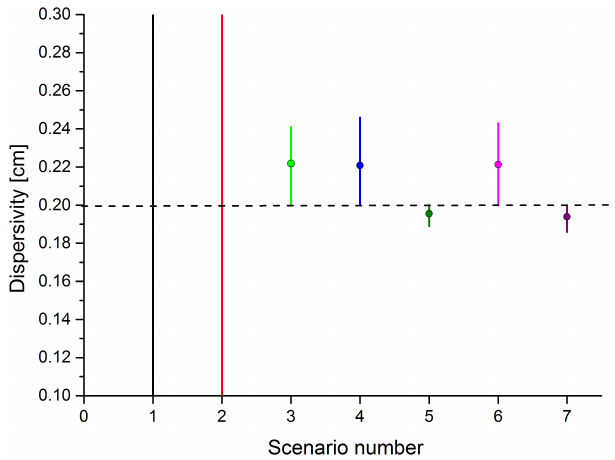
Figure 12. Posterior mean values and 95% confidence intervals of the shape parameter α for the different scenarios.